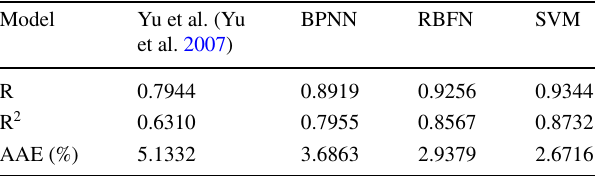
Table 6 Comparison of results between the empirical correlation and the AI techniques Model